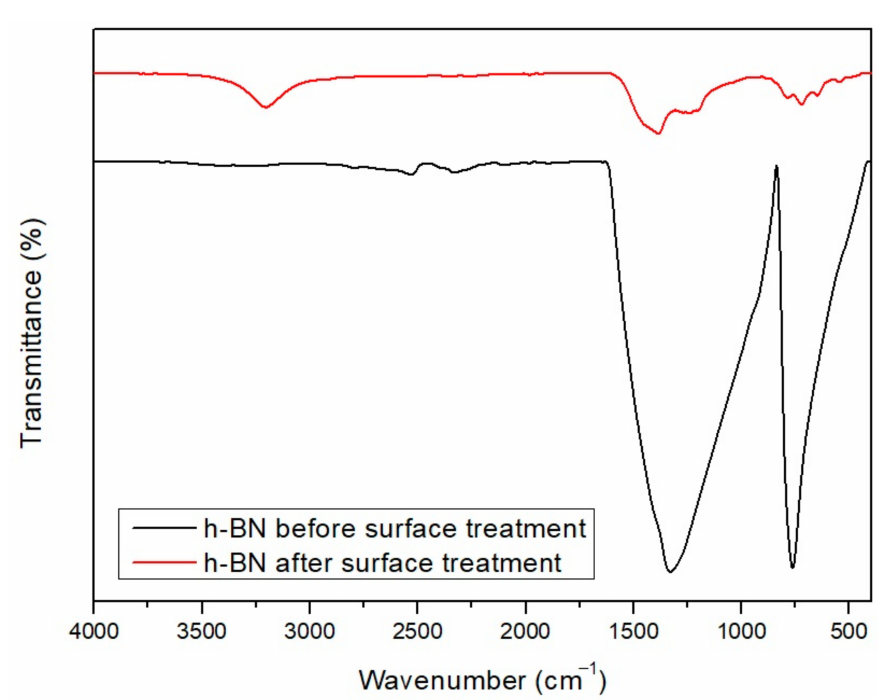
Figure 12. FT-IR spectrum of pure h-BN and surface-modified h-BN. SEM images and EDS mapping pictures for Boron element after introducing h-BN into APA resin are shown in Figures 13 and 14, respectively. In the case of APA-containing pure h-BN, significant agglomeration was observed. However, when surface-modified h-BN was added, it showed a relatively dispersed state. In addition, it was verified that when the amount of h-BN was increased, a slight aggregation of the h-BN particles was exhibited.